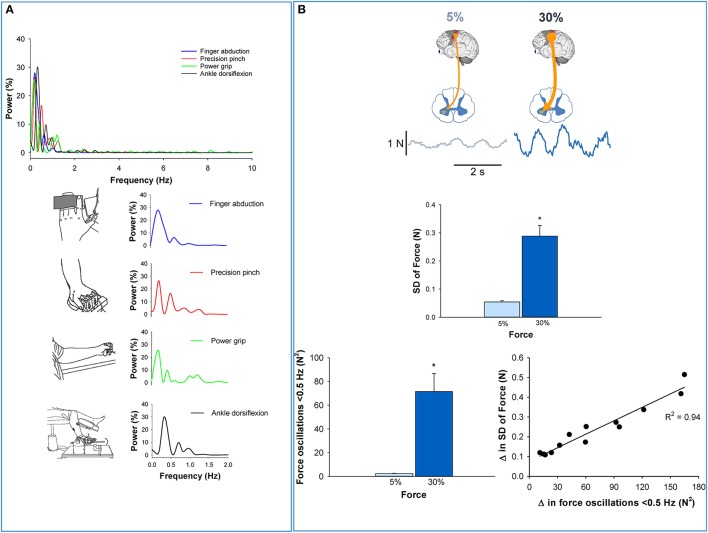
Low-frequency oscillations in the force output. (A) The power spectrum of force during various constant contractions (Top). Regardless of the effector performing the task, the majority of the power occurs below 1 Hz. Specifically, over 80% of the power for finger abduction, pinch grip, power grip, and ankle dorsiflexion occurs below 1 Hz. In addition, the peak oscillation is observed below 0.5 Hz. These findings suggest that low-frequency oscillations in force are independent of the type (upper or lower limb) or number (single or multi-digit) of effectors that are necessary to perform the task. (B) Top row shows that the voluntary drive from the higher centers to the spinal motor neurons increases when young adults exert a higher amount of force from 5% (light blue) to 30% (dark blue) MVC (top row) (Neto et al., 2010). The middle row shows that force variability increased with stronger voluntary drive (from 5 to 30% MVC). In the bottom row, we show that oscillations in force below 0.5 Hz also increased with higher voluntary drive (30% MVC). The increase in force variability with voluntary drive was strongly related (R2 = 0.94, p < 0.05; Moon et al., 2014) to increased oscillations in force below 0.5 Hz (bottom row–right). Thus, this figure shows that oscillations in force below 0.5 Hz increase with the strength of the voluntary drive and are detrimental to force precision.